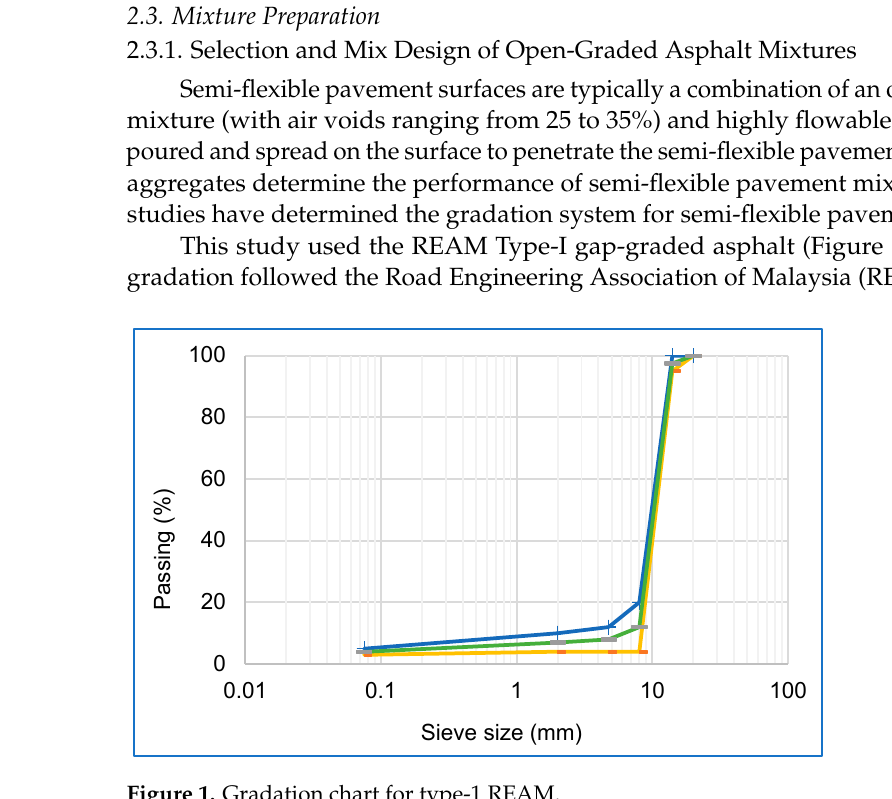
Figure 1. Gradation chart for type-1 REAM.